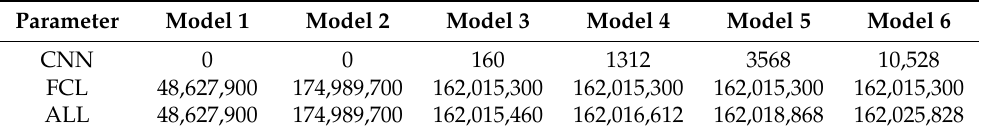
Table 6. Trainable parameters of Group A.